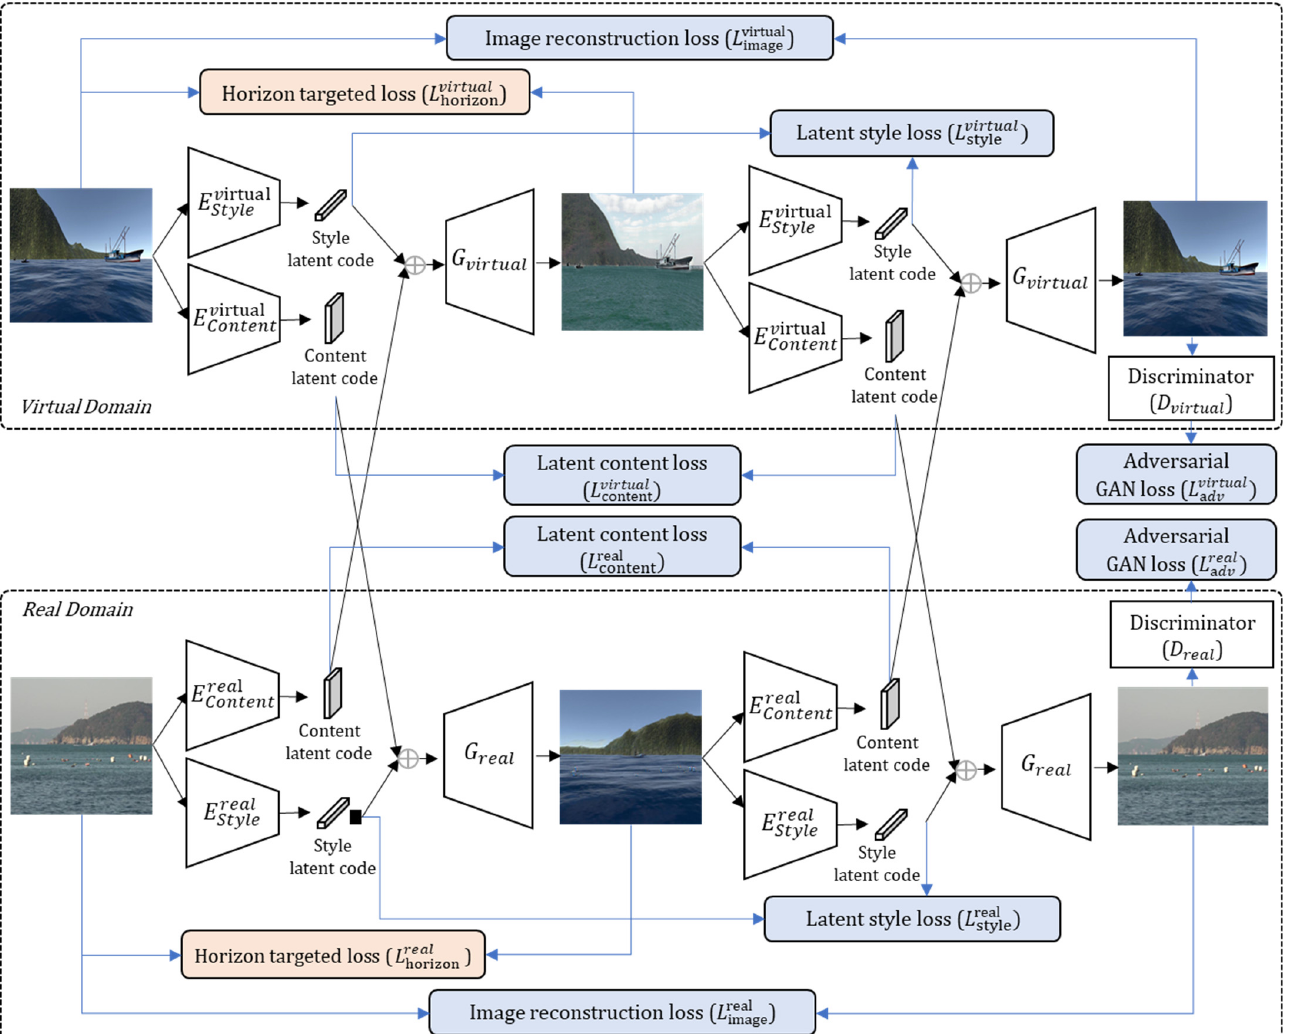
Figure 4. Architecture of training process of the generator.